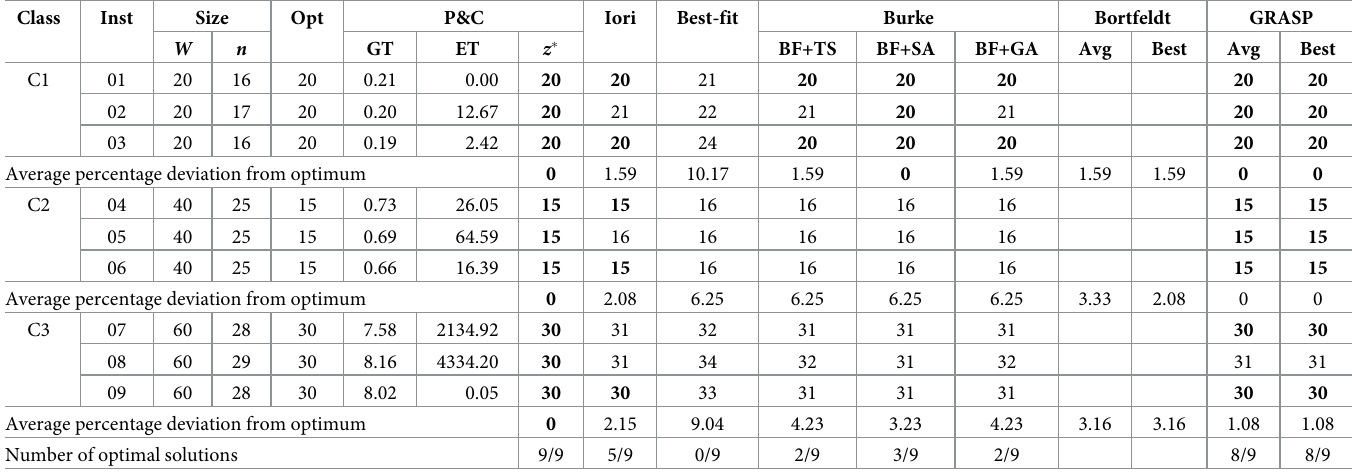
Table 5. Experimental results for hopper